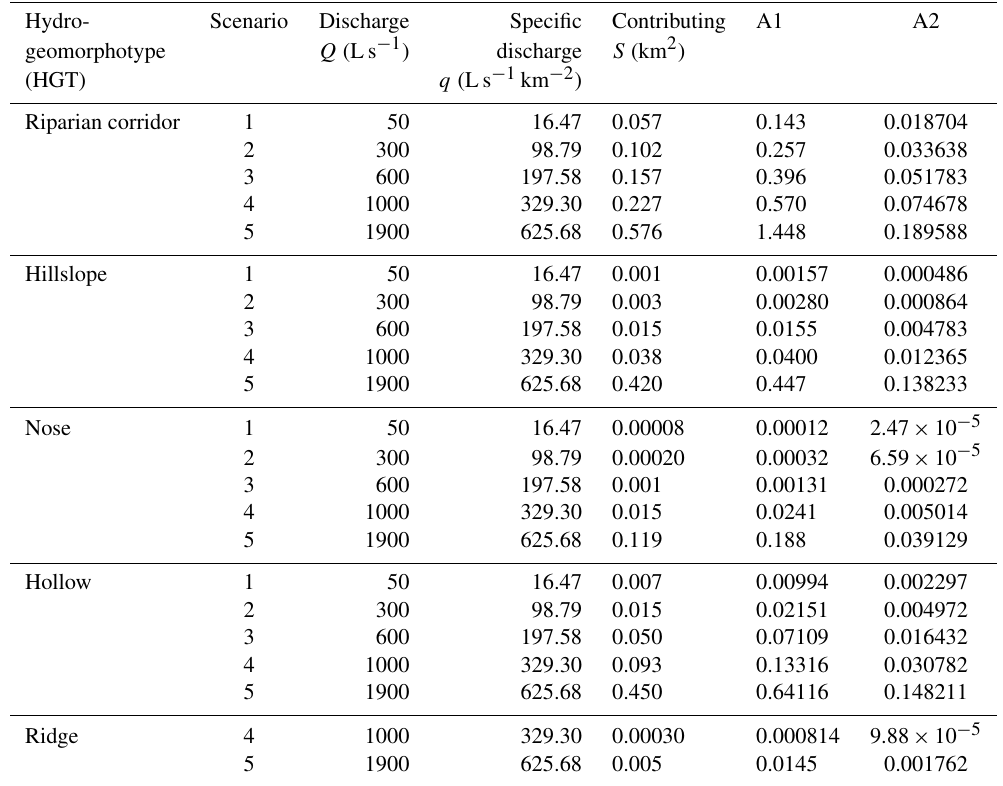
Table 4. Synoptic values of the Q -EC scenarios and contributing areas ( S ) values for each hydro-geomorphotype. Legend: q is the specific discharge calculated for the catchment area; A1 is the ratio between the contributing area and the hydro-geomorphotype; A2 is the ratio between the contributing area and the catchment